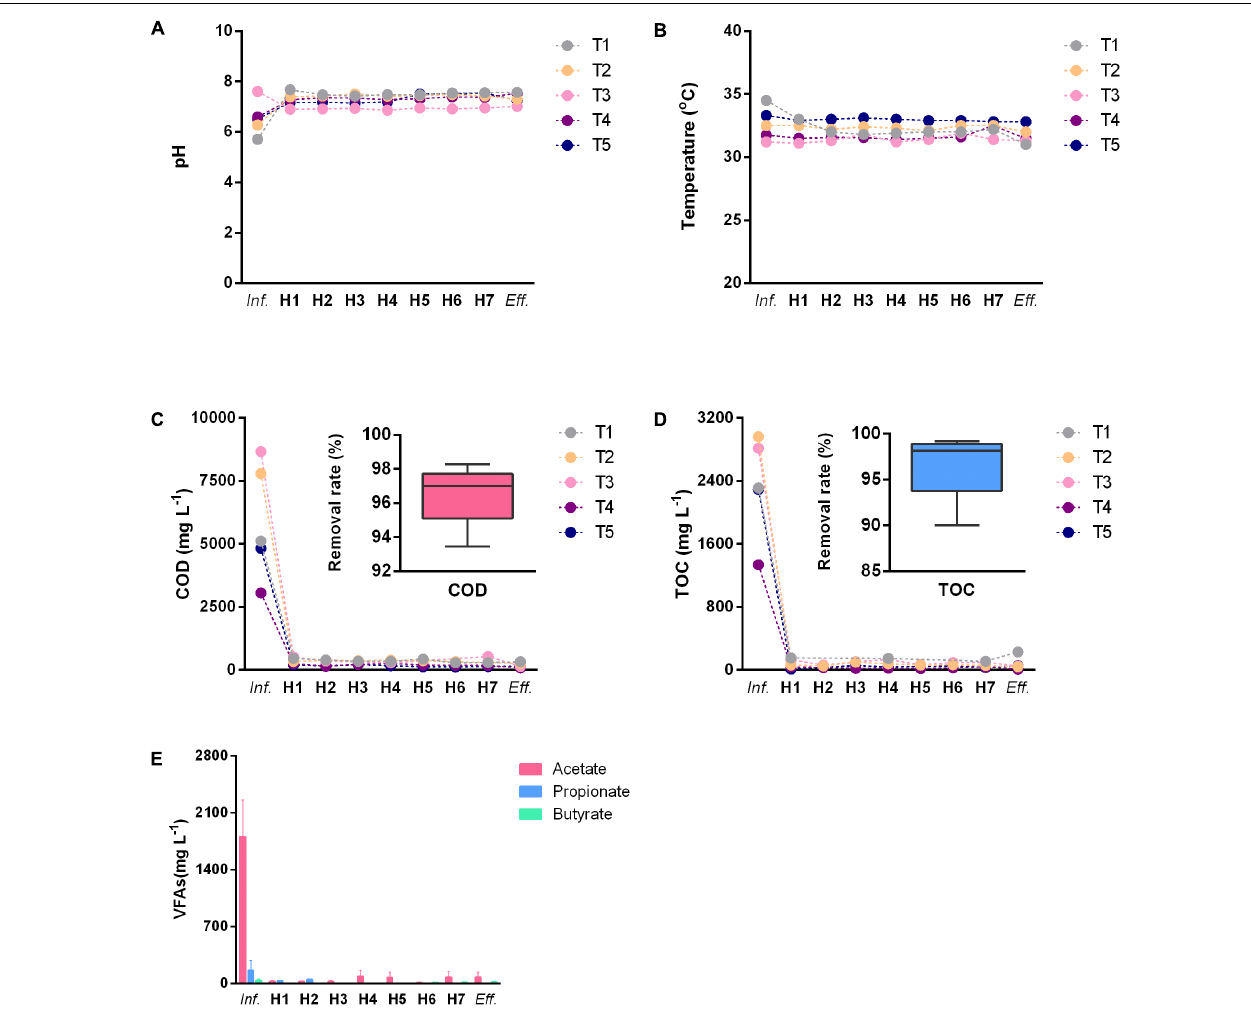
FIGURE 1 | Wastewater treatment performance of AnaEG. (A) pH of wastewater. (B) Temperature of wastewater. (C) COD concentration and removal rate. (D) TOC concentration and removal rate. (E) VFAs of wastewater. Abbreviations of Inf. and Eff. represented influent and effluent, T1–T5 represented the five sampling time points, H1–H7 represented the seven sampling heights of the